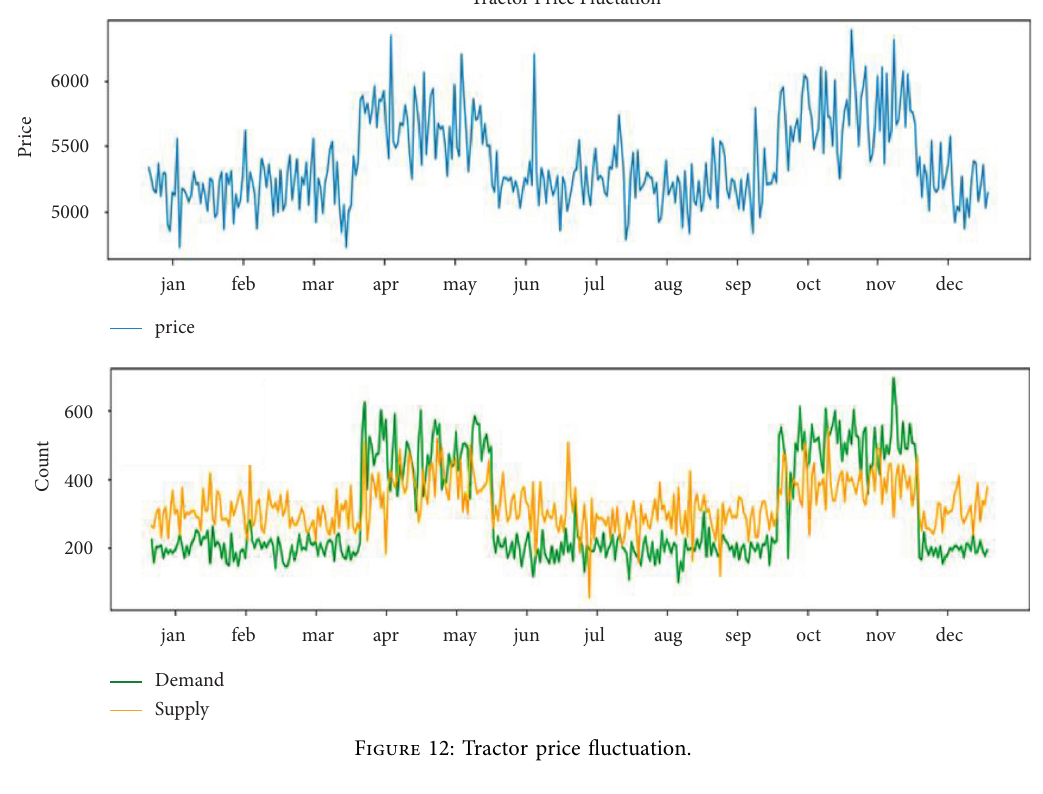
Figure 12: Tractor price fluctuation.